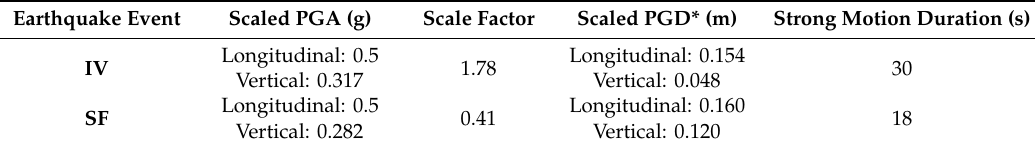
Table 2. Information of two strong ground motions. PGA: peak ground acceleration, SF: San Fernando.